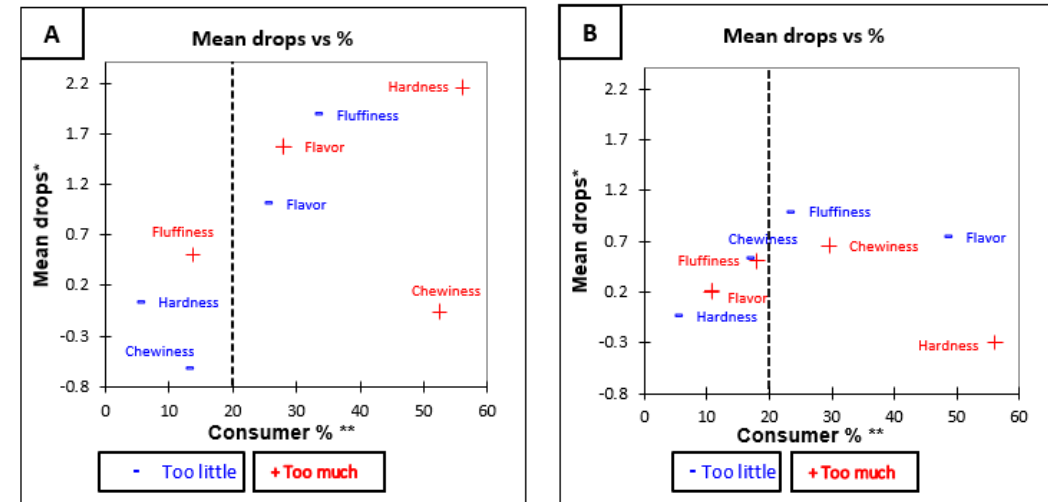
Figure 7. Mean drop plots for Medium Grain rice variety after tasting ( A ) Medium Grain Brown and ( B ) Medium Grain White. * Mean drop is the decrease in liking compared to the mean liking of those who rated the attribute as JAR. ** Consumer % are the consumers which judged an attribute as not ideal (Just About Right). The attributes with large percentages of consumers and penalties are in top right quadrant of the plot, which illustrates the critical points of the product [34].